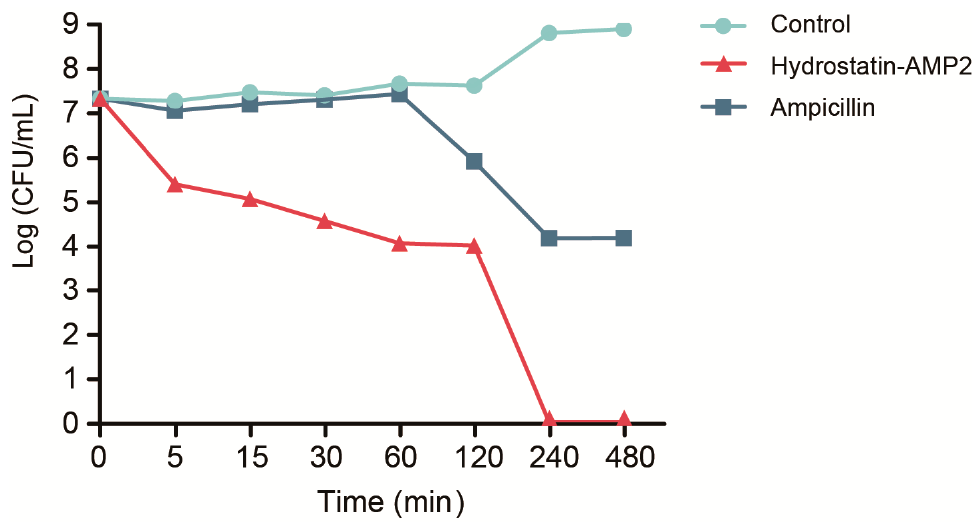
Figure 4. Killing kinetics of Hydrostatin-AMP2 against E. coli . After incubation with Hydrostatin- AMP2 or Ampicillin for a different time, CFU was determined by serial dilution agar plating method. Data represent mean ± SD values of three independent experiments performed in triplicate.